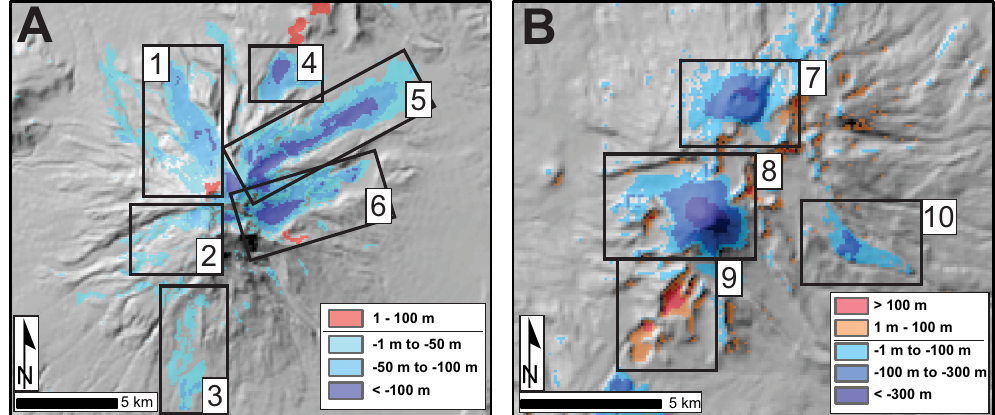
º Figure 4. Geologically informed reconstruction of pre-15ka topography, displayed as a difference (in metres) from modern topographic boundary conditions, for glacier model domains of (a) Mt Ruapehu (1: Whakapapa flows (Hackett and Houghton, 1989); 2: Holocene flows in upper Mangaturuturu (Conway et al., 2016); 3: Rangatauanui flow; 4: Saddle Cone flow(s); 5–6: post-LGM flows in and adjacent to Mangatoetoenui valley (Gamble et al., 2003)) and (b) Tongariro massif (7: North Crater; 8: Mt Ngauruhoe; 9: Tama Lakes explosion craters;